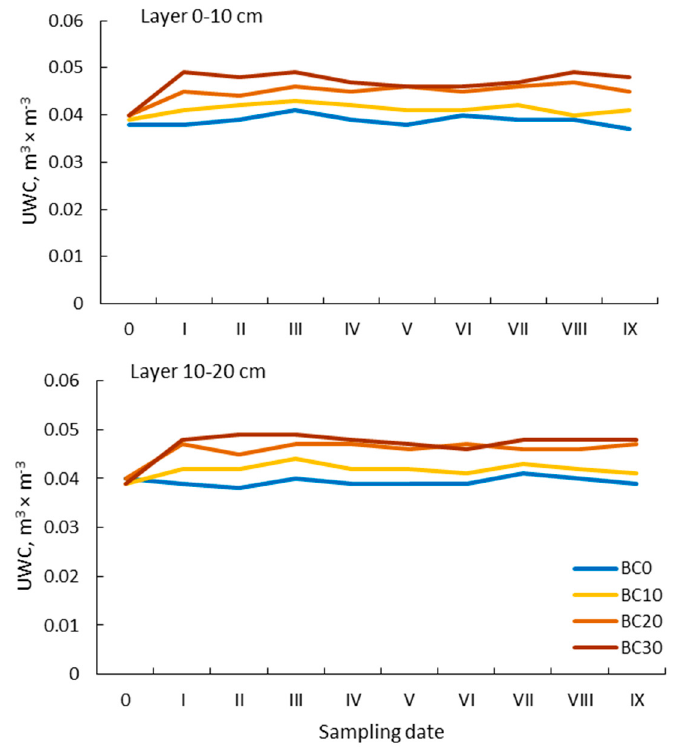
Figure 9. Unavailable water content (UWC). Explanations as for Figure 1.